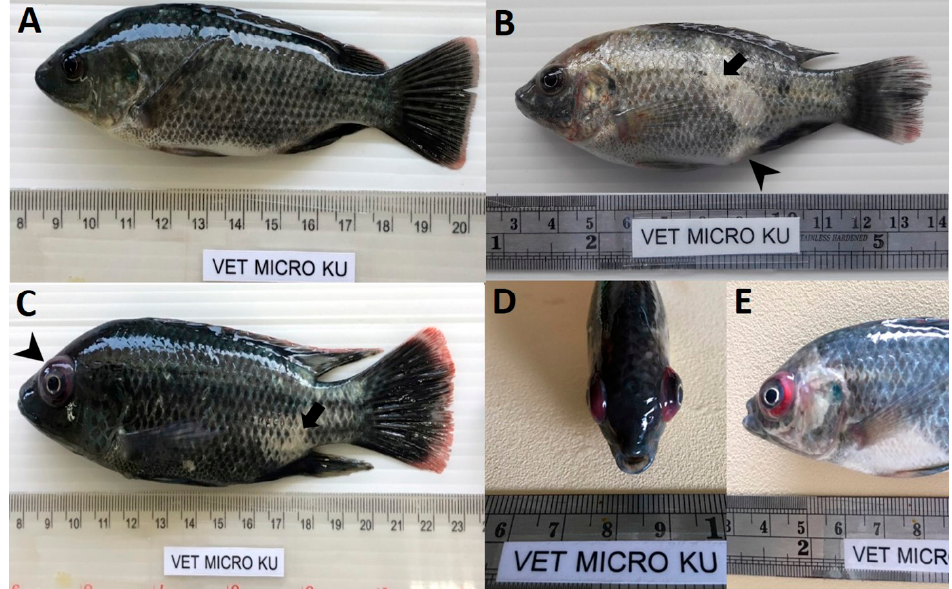
Figure 2. Clinical signs of TiLV infection in Mozambique tilapia ( Oreochromis mossambicus ). ( A ) Control uninfected fish. ( B ) Fish infected with TiLV at low viral concentration (1 × 10 3 TCID 50 /mL), skin erosion (arrow) and abdominal swelling (arrowhead). ( C ) Fish infected with TiLV at high viral concentration (1 × 10 5 TCID 50 /mL), skin erosion (arrow) and exophthalmos (arrowhead). ( D , E ) Fish infected with TiLV at high viral concentration (1 × 10 5 TCID 50 /mL), exophthalmos and congestion of the eye.